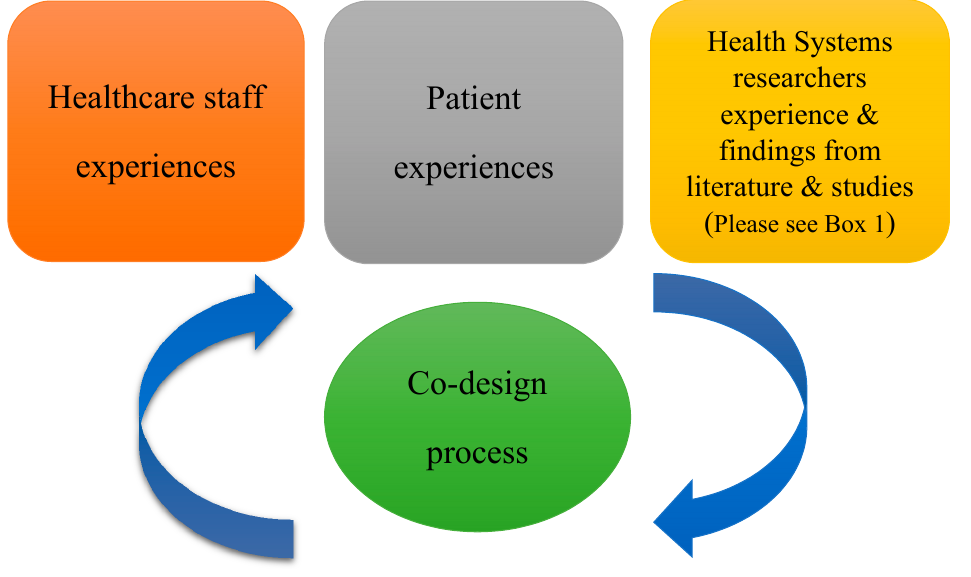
Figure 1. Participants and experiences in the co-design process.